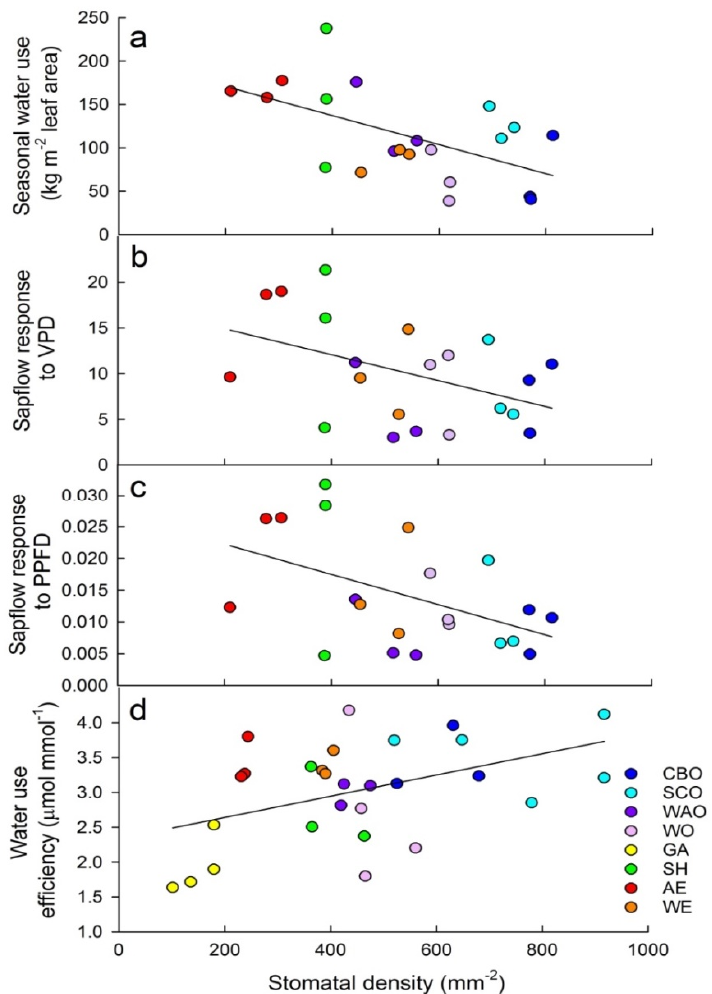
Figure 2. Mean whole crown-level stomatal density (mm − 2 ) vs. ( a ) individual water use across the growing season (kg H 2 O m − 2 leaf area), ( b ) slope of the relationship between daily sapflow and mean daytime vapor pressure deficit (“sapflow response to VPD”), ( c ) slope of the relationship between daily sapflow and maximum daily photosynthetic photon flux density (“sapflow response to PPFD”) and ( d ) leaf-level stomatal density (mm − 2 ) vs. water use e ffi ciency ( µ mol CO 2 mmol − 1 H 2 O) in leaves measured for gas exchange. Dark blue circles = cherrybark oak (CBO), light blue circles = swamp chestnut oak (SCO), dark purple circles = water oak (WAO), light purple circles = willow oak (WO), yellow circles = green ash (GA) green circles = shagbark hickory (SH), red circles = American elm (AE), orange circles = winged elm (WE).